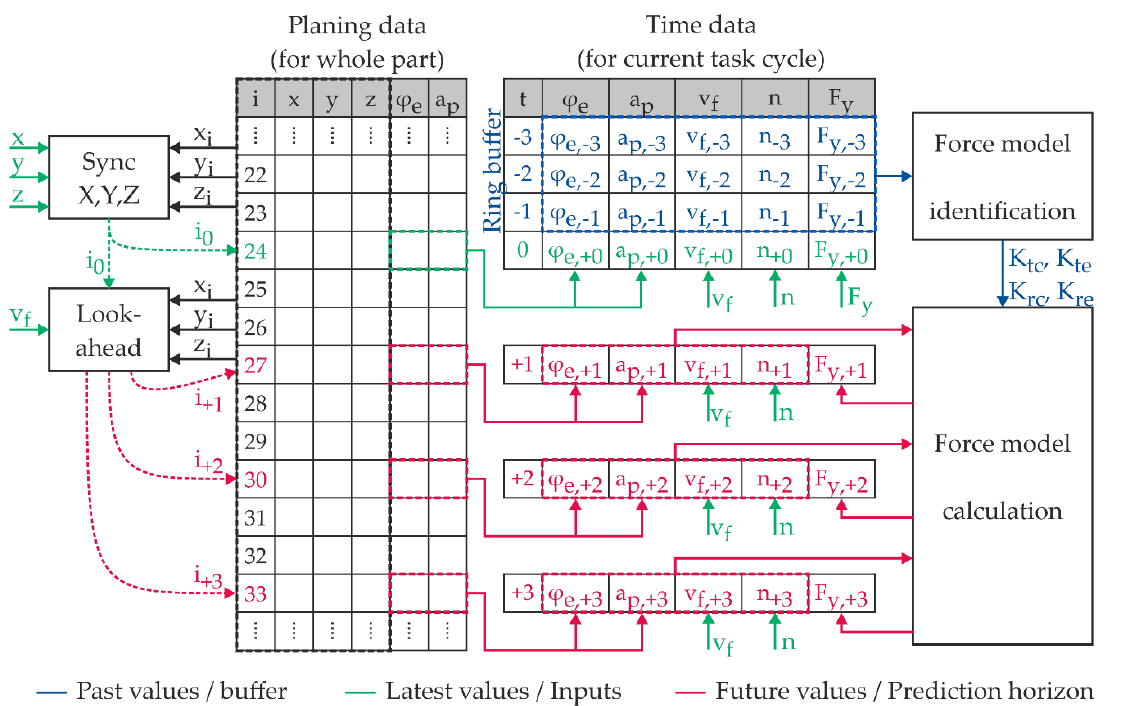
Figure 7. Process force prediction.